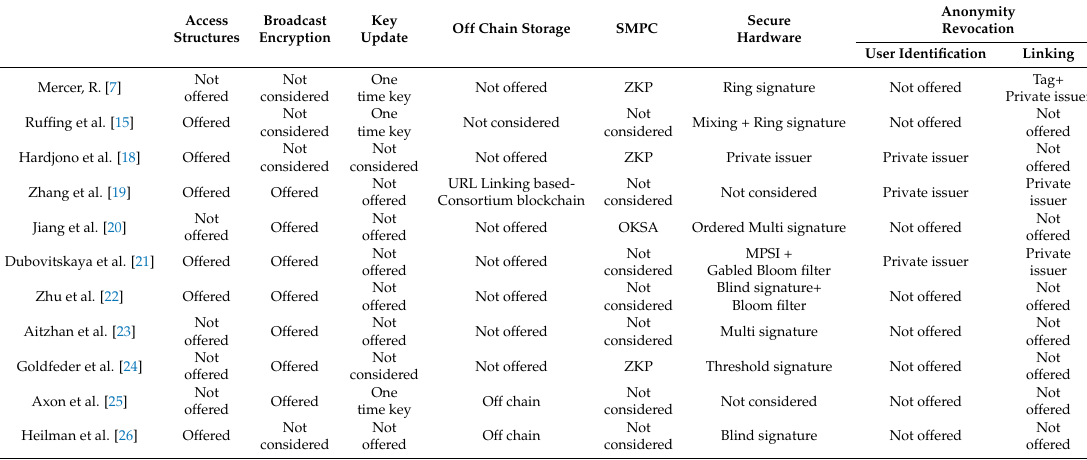
Table 2. A scheme classification on options for privacy in blockchain. Access Broadcast Structures